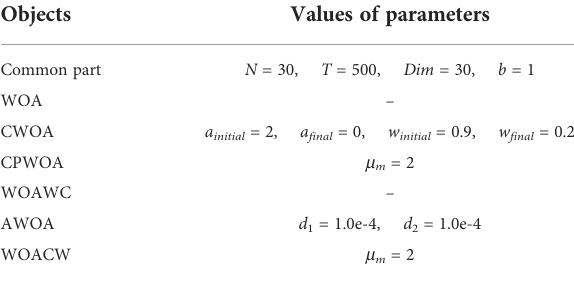
TABLE 3 Experimental parameters of the six WOAs. Objects Values of parameters constant logarithmic function when plotting, and the convergence curves of eight benchmark functions are shown in Figure 1.